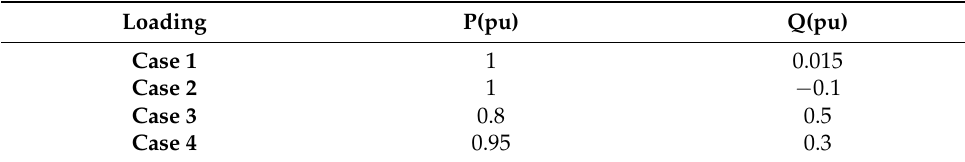
Figure 9. Electrical output power response for a six-cycle fault disturbance with case 1. Figure 10. The field voltage for a six-cycle fault disturbance with case 1.